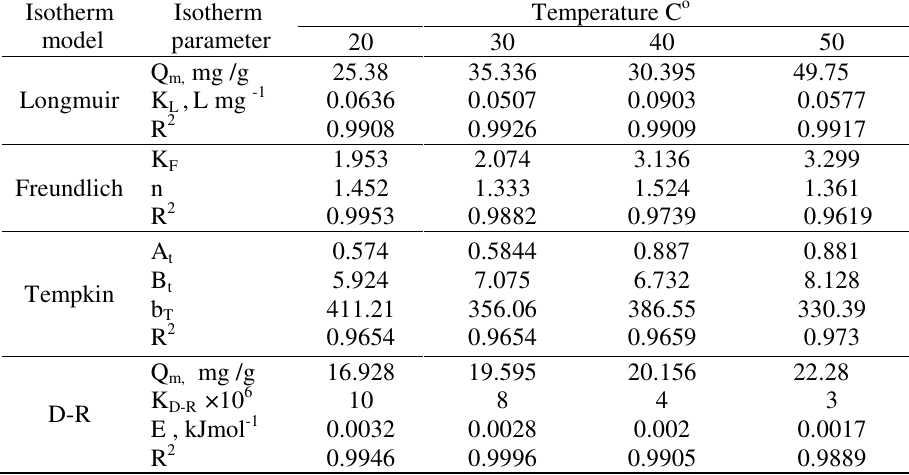
Table 2. Comparison of the coefficients isotherm parameters from chromium (10,20,30,40 mg/L) adsorption onto FMPGP